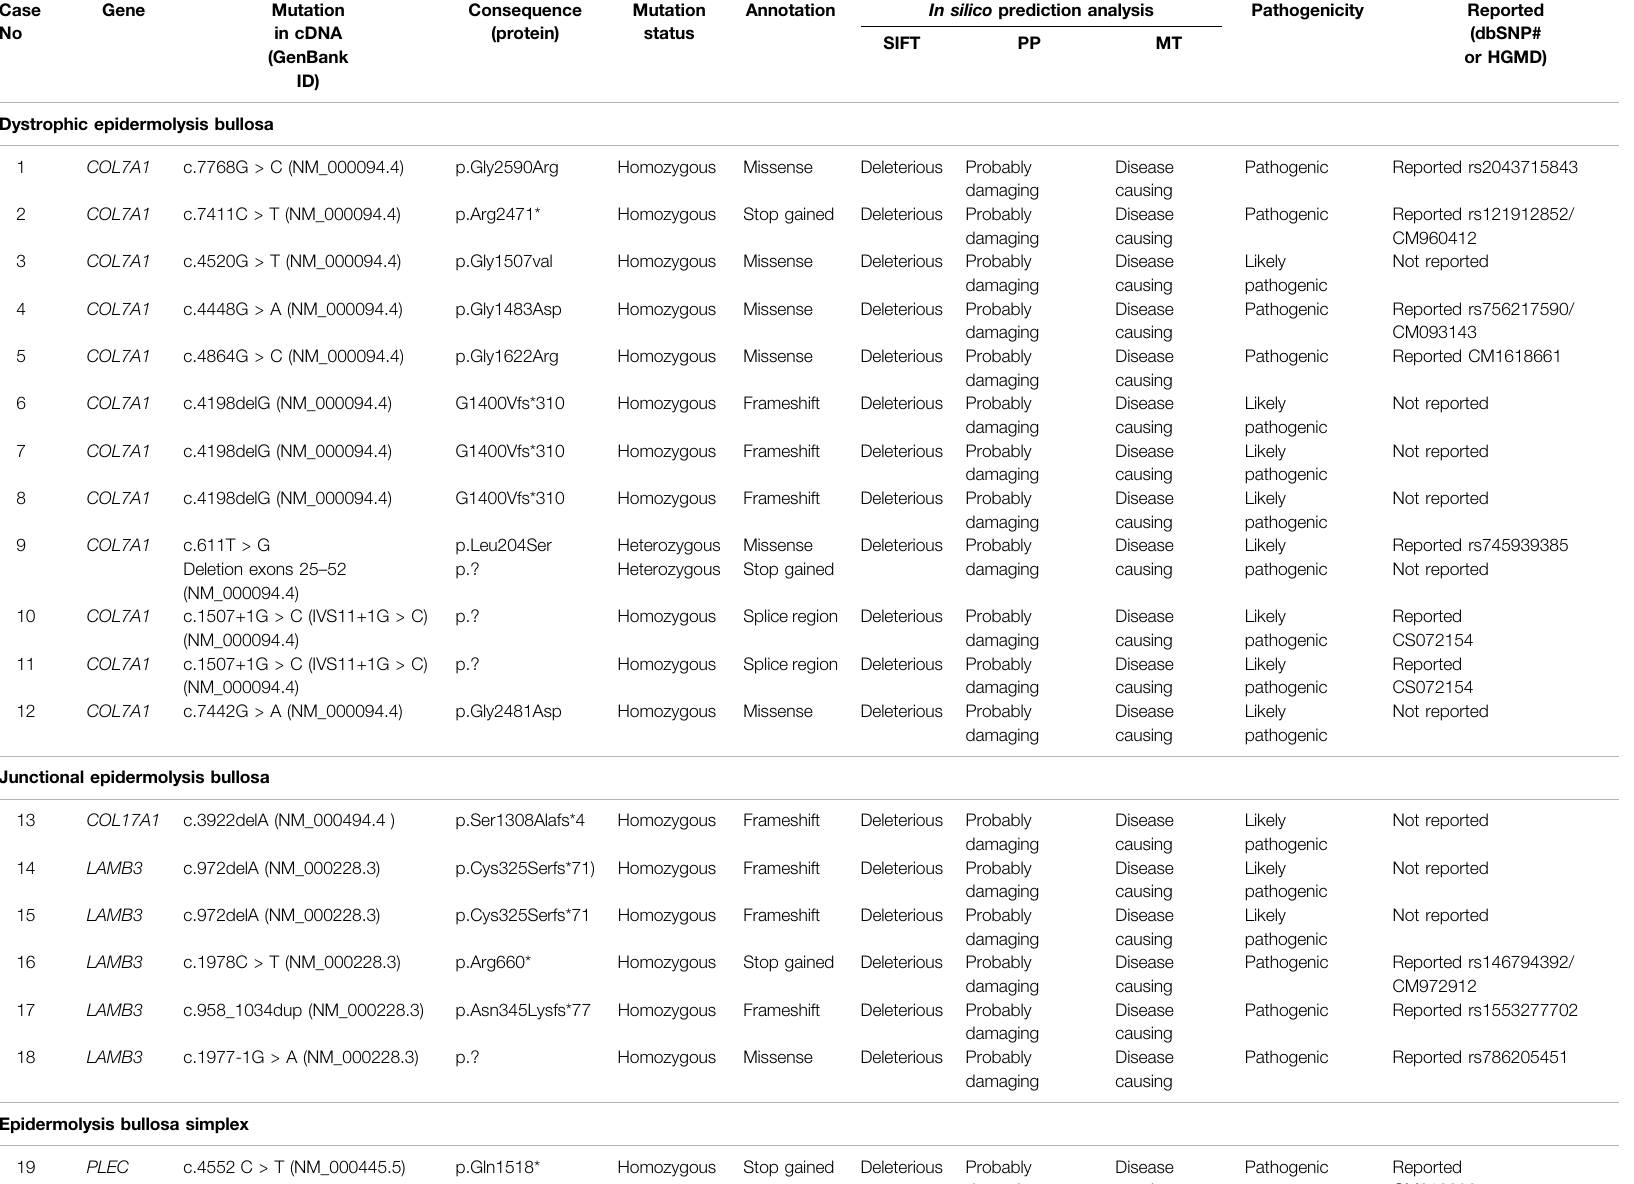
TABLE 2 | Genes, variants, mutation types, and novelty status per EB classi fi